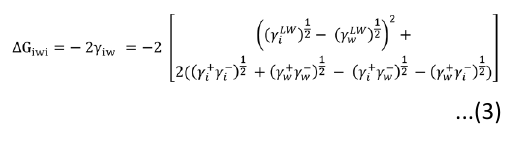
Table 1. Energy characteristics of solvents used for contact angle measurements 23 : γ Lw : Van der Waals component of surface free energy Solvents; γ + : Electron acceptor component of free surface energy of solvents; γ - : Electron donor component of free surface energy of solvents: Solvent Formule γ Lw (mJ/ m 2 ) γ ab (mJ/ m 2 ) γ + (mJ/ m 2 ) γ - (mJ/ m 2 ) Water H O 21,8 51,0 25,5 25,5 2 Diiodomethane CH I 50,8 ~0 ~0 ~0 2 2 Formamide CH NO 39,0 3